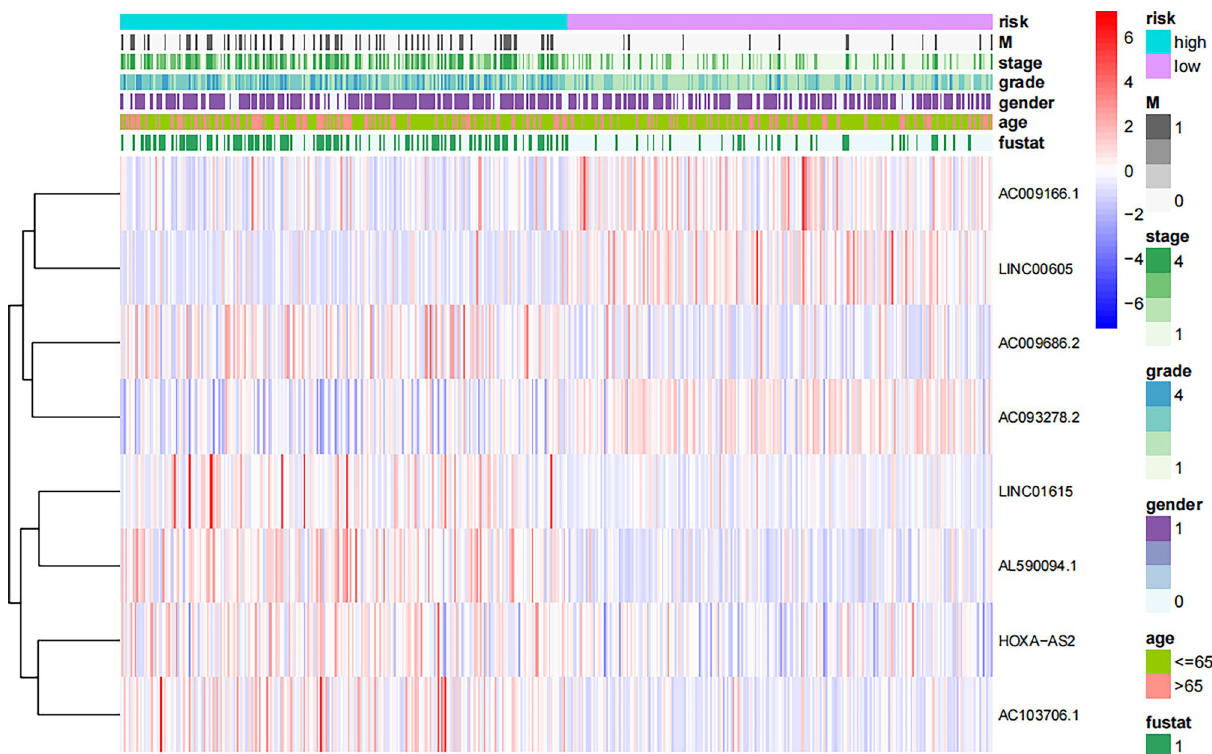
Figure 6. Heatmap (Purple: high expression; brilliant blue: low expression ) for the connections between, clinicopathologic features and the risk groups (R software (version 4.2.1, URL: http:// www.r- proje ct. org)). lncRNAs, long noncoding RNAs; T, tumor; M,